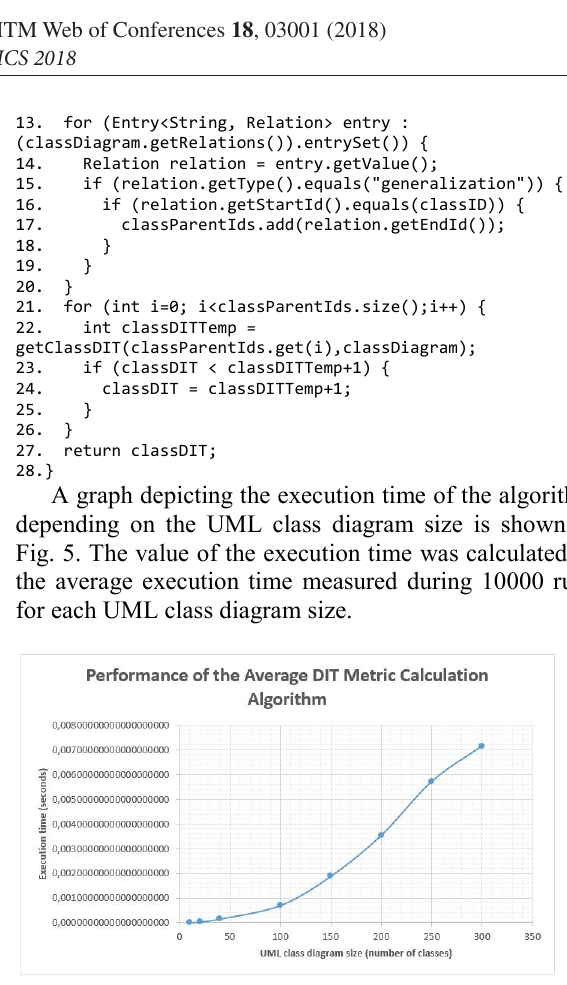
Fig. 5. Performance of the Average DIT Metric Calculation Algorithm